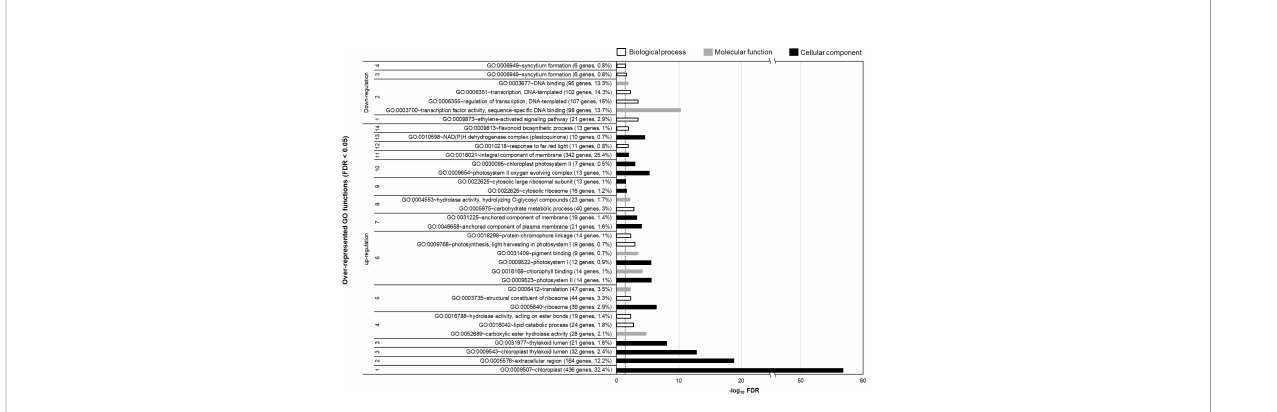
FIGURE 3 Over-represented Gene Ontology (GO) functions of CO 2 -responsive genes (false discovery rate [FDR]< 0.05). The over-represented GO functions were determined by DAVID functional annotation tool (https://david.ncifcrf.gov). The parenthesis indicates the number and percentage of genes involved in each Go function. The bar color represents the different GO functions. The dashed line indicates the threshold (-log 10 0.05) for statistical signi fi